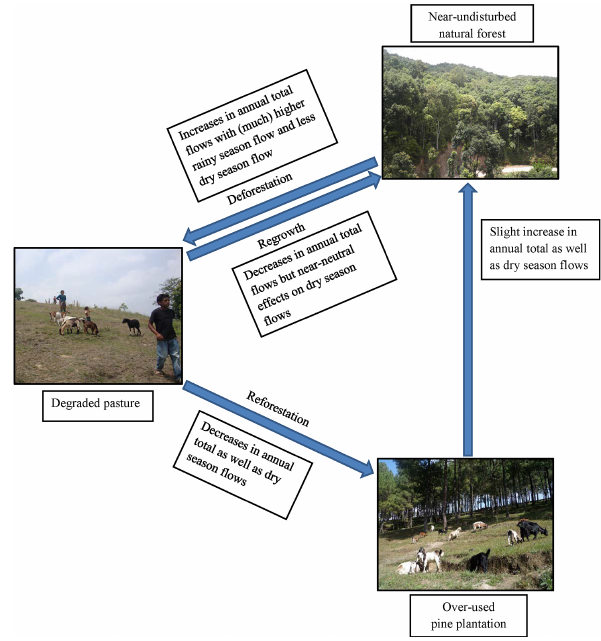
Figure 5. Conceptual diagram of the effect of land-cover transfor- mation on annual total and dry season flows in the study area as well as other comparable regions with similar land-cover transfor-